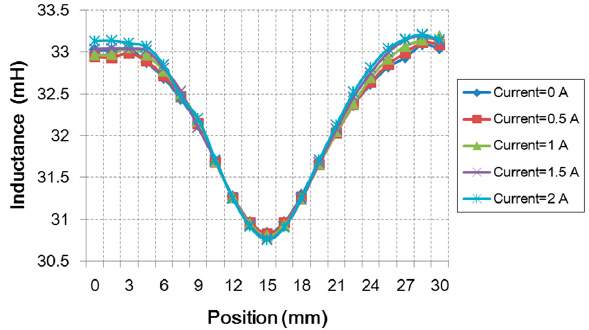
Figure 7. Inductance profiles of the winding responsible for the linear part.